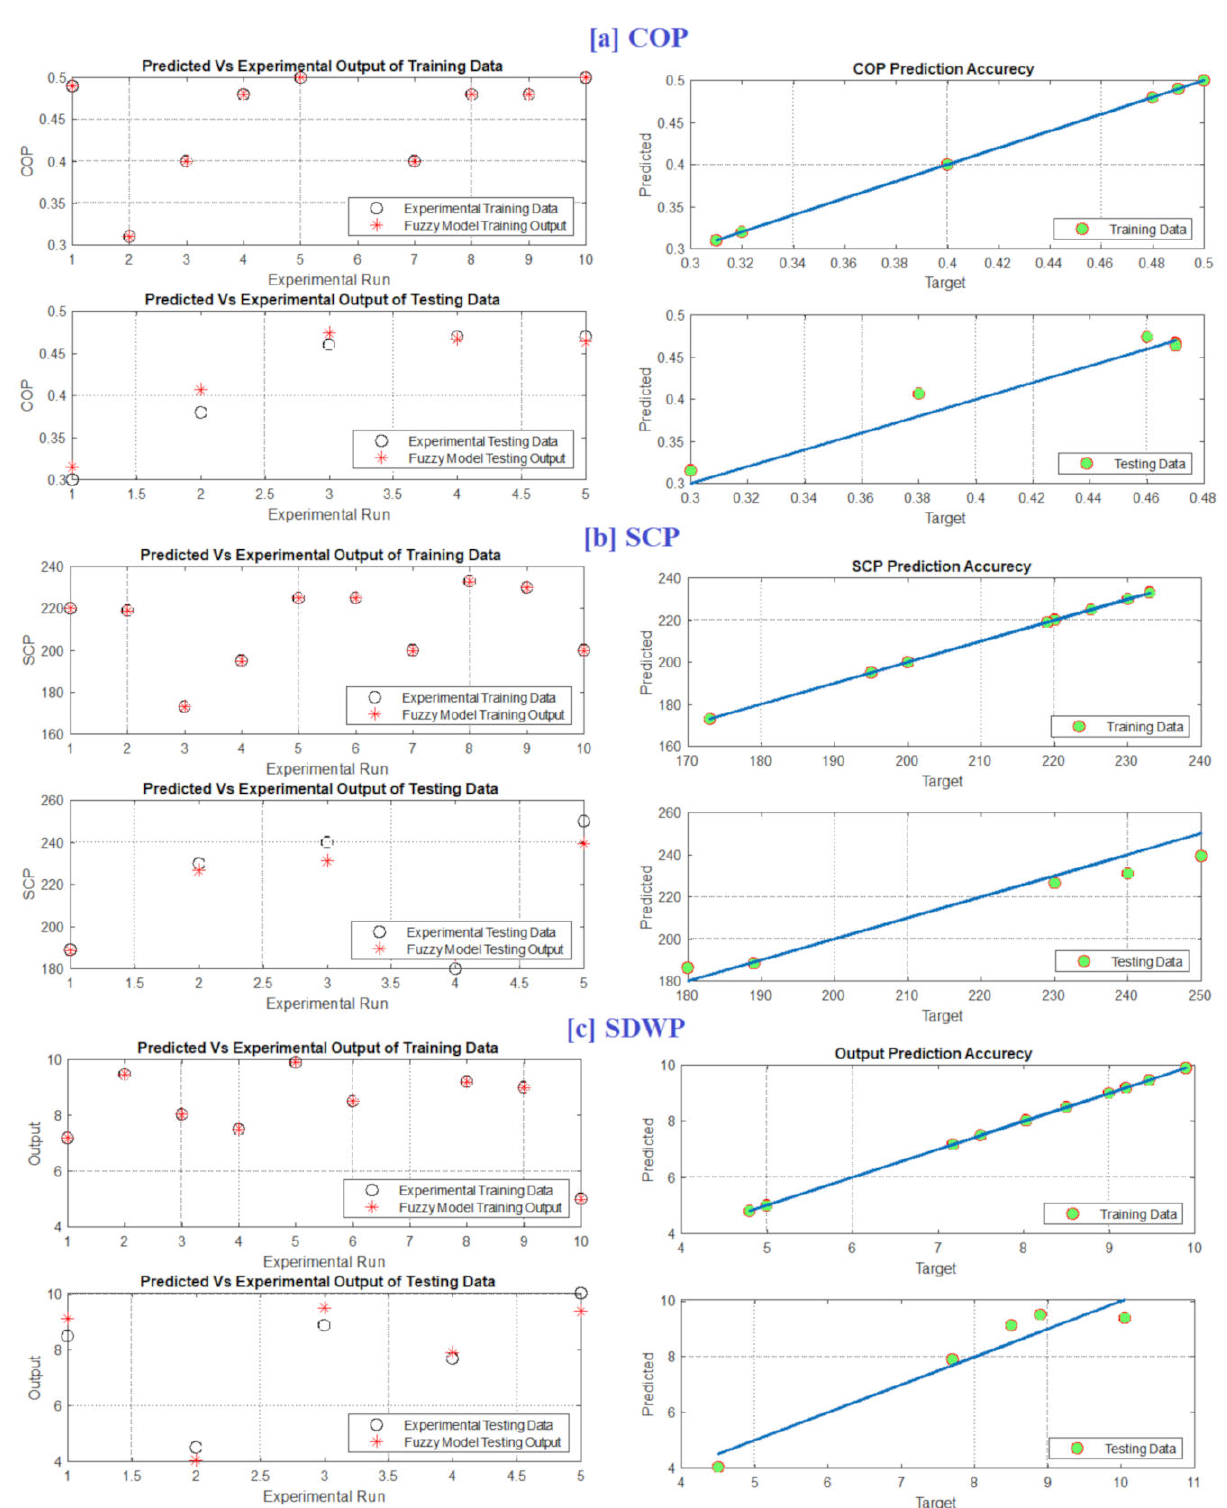
Figure 7. Comparison of the training and testing data ( a ) COP; ( b ) SCP, and ( c )